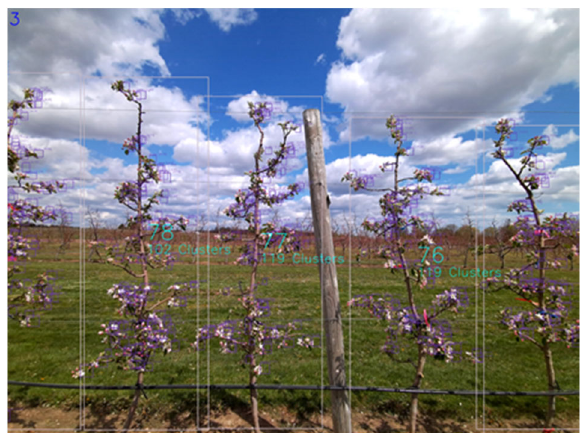
Figure 13. Snapshot of the detection video generated by the system. Note that each tree was identified (by a bounding box and large number in the center) and assigned the number of estimated clusters (smaller number below the tree ID number).